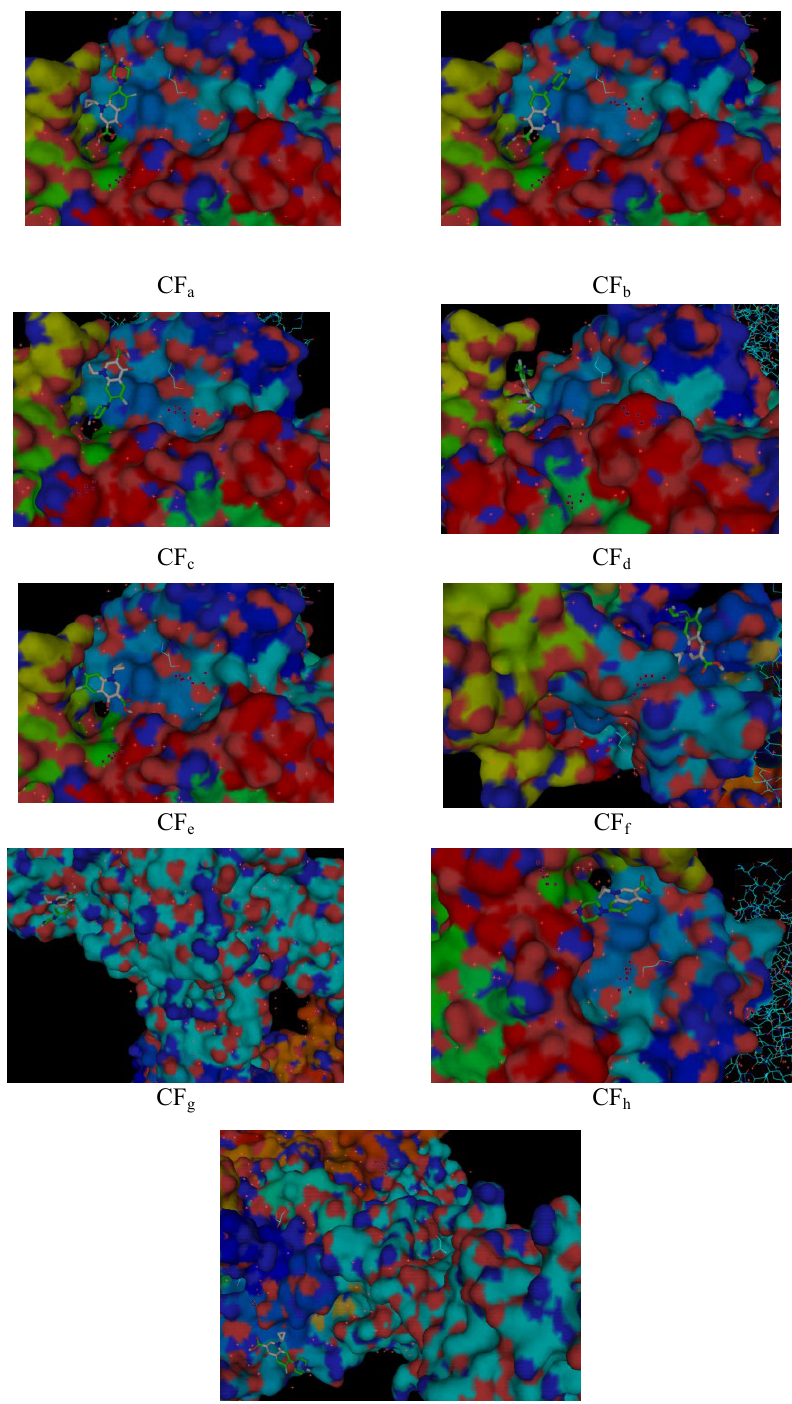
Figure 1. Different modes of